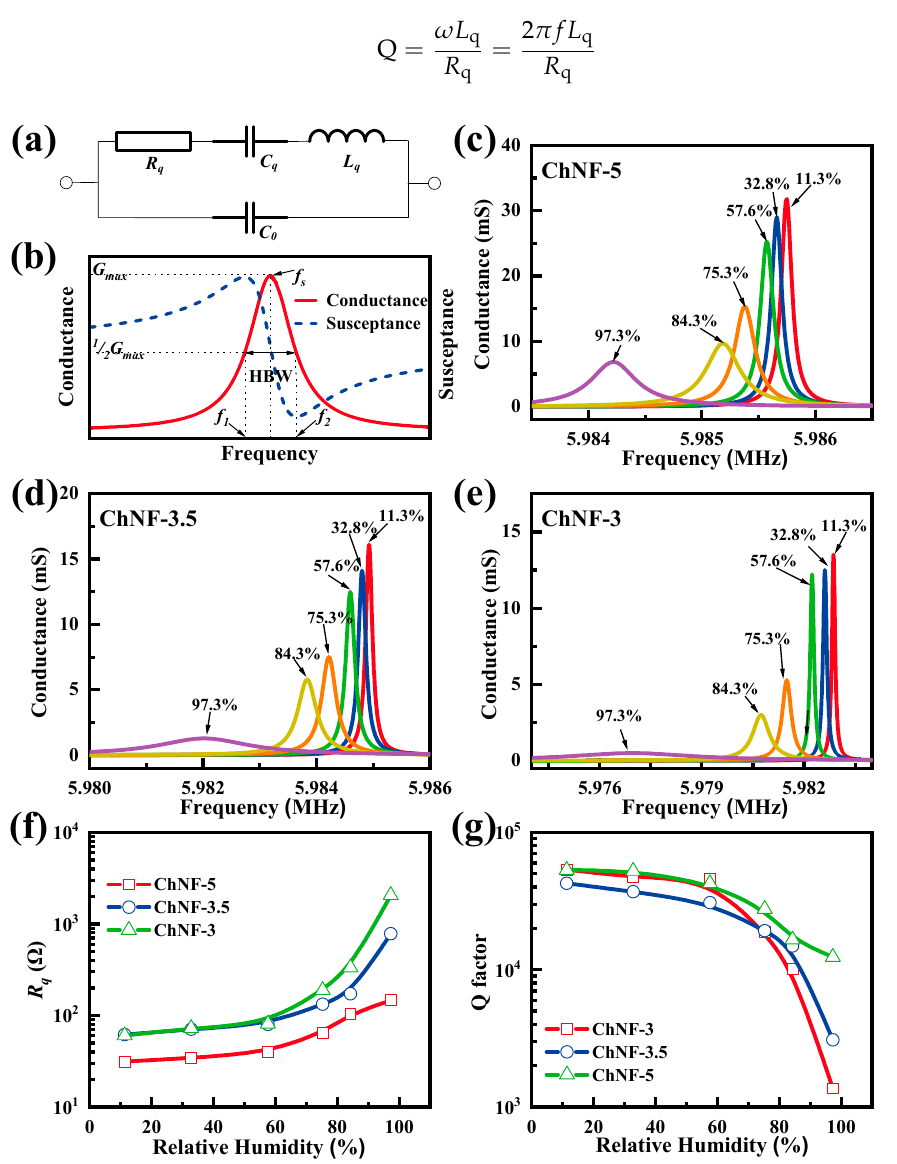
Figure 4. ( a ) Schematic of the Butterworth–Van Dyck (BVD) equivalent circuit, and ( b ) the typical conductance and susceptance of the QCM sensor. The ( c – e ) conductances, ( f ) dynamic resistances, and ( g ) Q-factors of the ChNF-5, ChNF-3.5, and